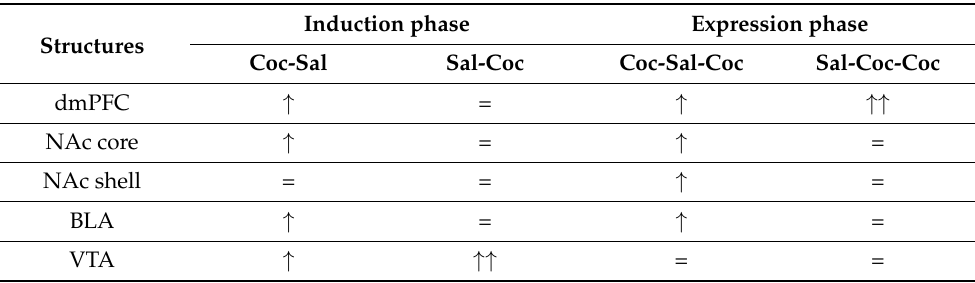
Comparative summary of c-Fos expression during both phases of the behavioral sensitization